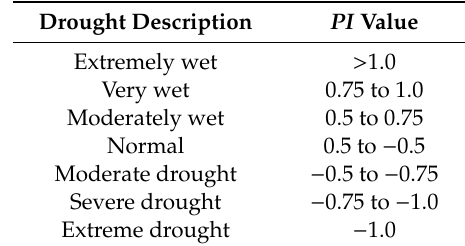
Table 1. Precipitation index ( PI ) drought